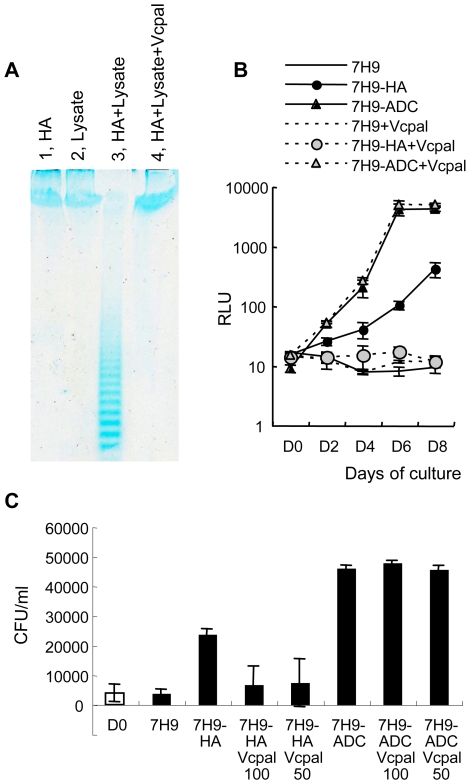
Hyaluronidase activity in mycobacteria and the effect of hyaluronidase inhibitor on hyaluronan-dependent growth of BCG and M. tuberculosis.(A), One mg/ml of hyaluronan and 700 µg/ml of BCG cell lysate was mixed and incubated for 3 days in the presence (HA+Lysate+Vcpal) or absence (HA+Lysate) of ascorbic palmitate (Vcpal), an inhibitor of hyaluronidase. As controls, hyaluronan alone (lane 1, HA) or BCG cell lysate alone (lane 2, Lysate) was treated in the same way. Hyaluronan was precipitated by ethanol after phenol extraction and resolved in water. Then hyaluronan was fractionated by PAGE gel electrophoresis and visualized by staining with alcian blue. (B), BCG-Luc (0.01 OD at 630 nm) was cultured in carbon-starved 7H9 media (7H9), media containing hyaluronan (500 µg/ml) as a sole carbon source (7H9-HA), or complete 7H9-ADC media (7H9-ADC) in the presence or absence of 25 µM Vcpal (+Vcpal), an inhibitor of hyaluronidase. The growth of bacteria was monitored by luciferase activity. RLU, relative luciferase unit (RLU). The results are expressed as mean±the standard deviation (n = 3). (C), The effect of Vcpal on the growth of M. tuberculosis. M. tuberculosis H37Rv was cultured in carbon starved 7H9 media (7H9), media containing 100 µg/ml hyaluronan as a sole carbon source (7H9-HA), or conventional 7H9-ADC media (7H9-ADC) with or without 50 (50) or 100 (100) µM of Vcpal for 8 days (closed bars). Bacterial number was determined by plating dilutions for CFU on 7H9-OADC agar and compared to that of Time 0 (D0, open bar).